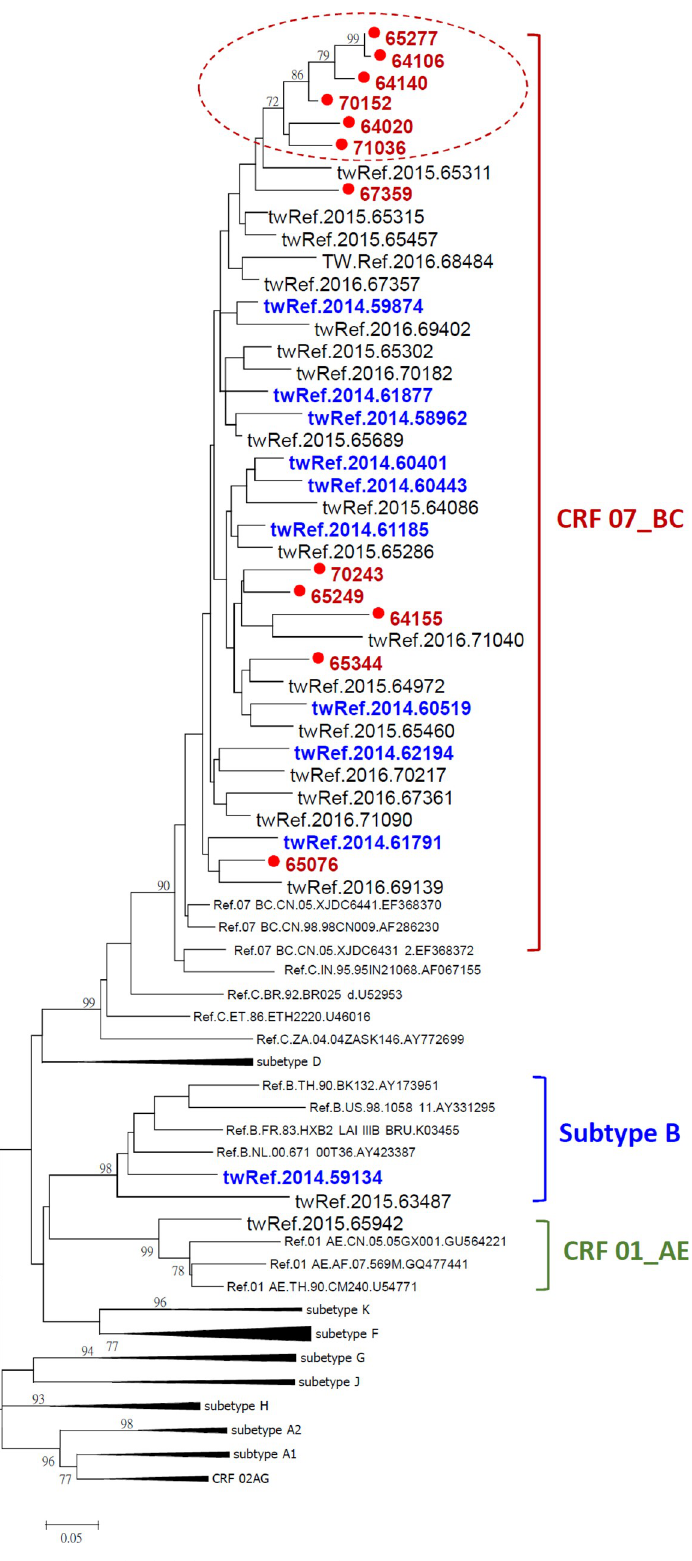
Fig 2. The result of phylogenetic tree